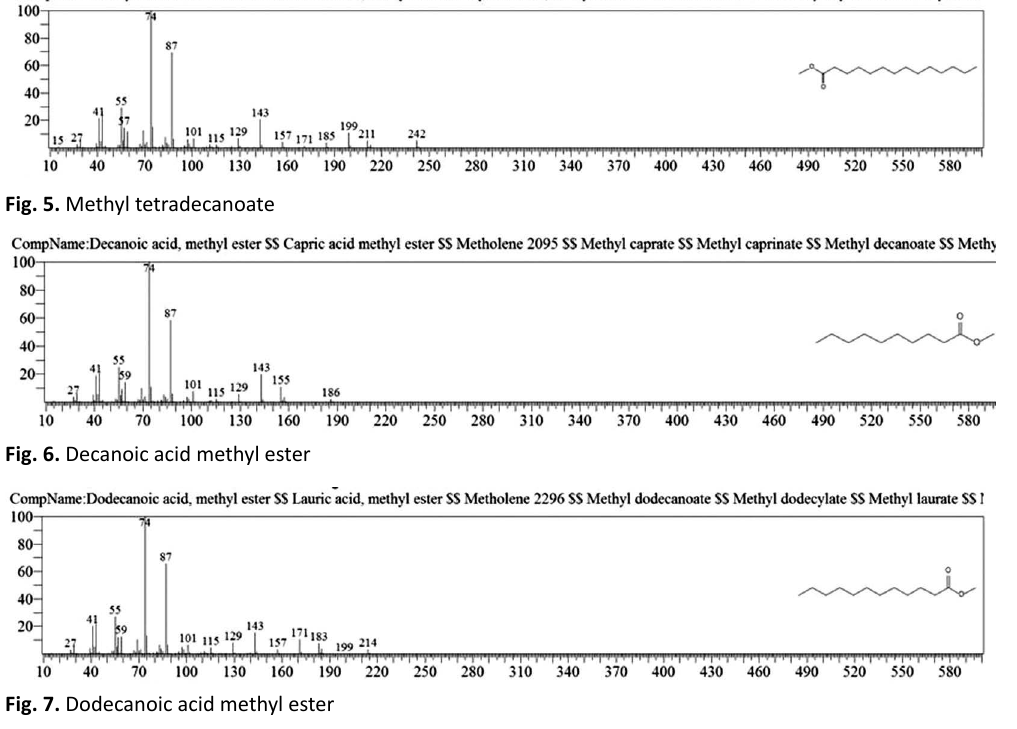
Fig. 4. 9-Octadecenoic acid methyl ester